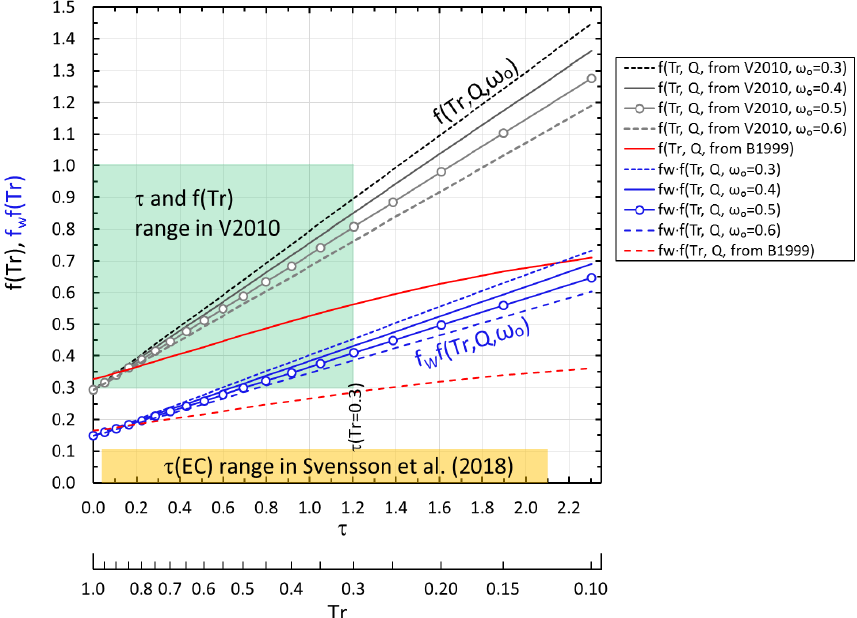
Figure 8. Loading correction functions derived from V2010 and O2010 for airborne BC particles collected on quartz filters (grey lines; f (Tr, Q , ω o ) ) and for BC particles mixed in water and filtered through similar quartz filters (blue lines; f w f (Tr, Q , ω o ) ). The green shading shows the range of optical depths and f (Tr) of the V2010 Pallflex filter calibration, and the yellow shading shows the range of optical depths of EC in snow presented by Svensson et al.